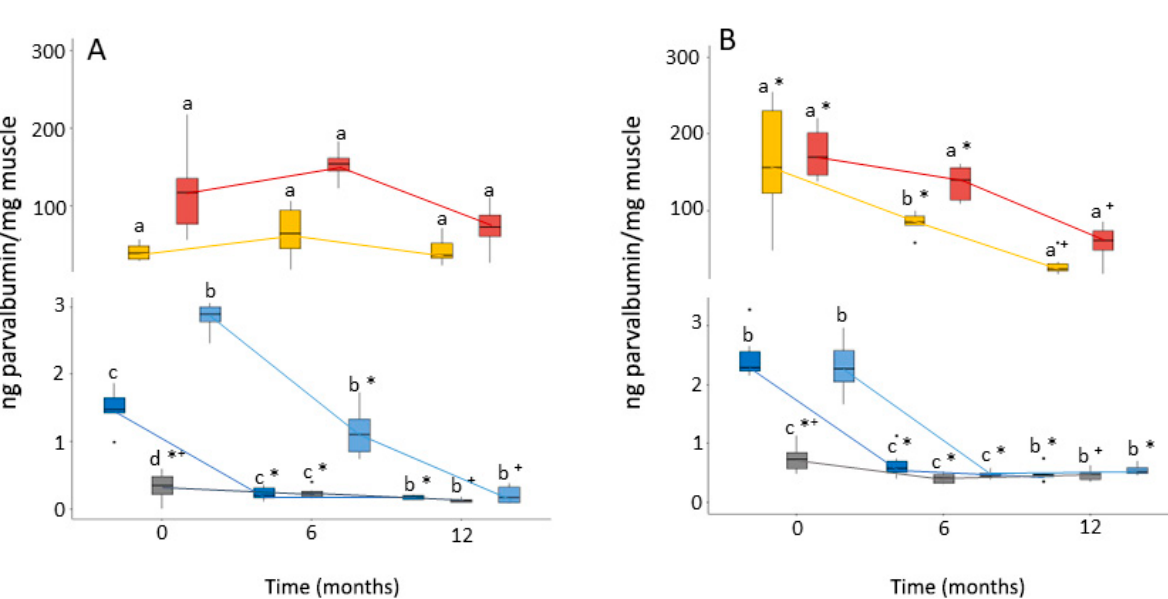
Figure 4. Box plots of European seabass ( A ) and gilthead seabream ( B ) parvalbumin conservation over time (t = 0, 6 and 12 months), with different treatments (Autoclave, Boiled, NaCl, Raw and Steam). Results are shown by quartiles (from Q1 to Q3) and the horizontal line in each box represents the median value. Lines outside the boxes represent the minimum and maximum. Significant differences (two-way repeated measures ANOVA, followed by paired t -test with Bonferroni correction) are shown by letters (a, b, c, d) in between treatments at each time point and by symbols (*, + ) in between time for each treatment. X -axis represents time (months) and y -axis the ng parvalbumin measured per mg of muscle.